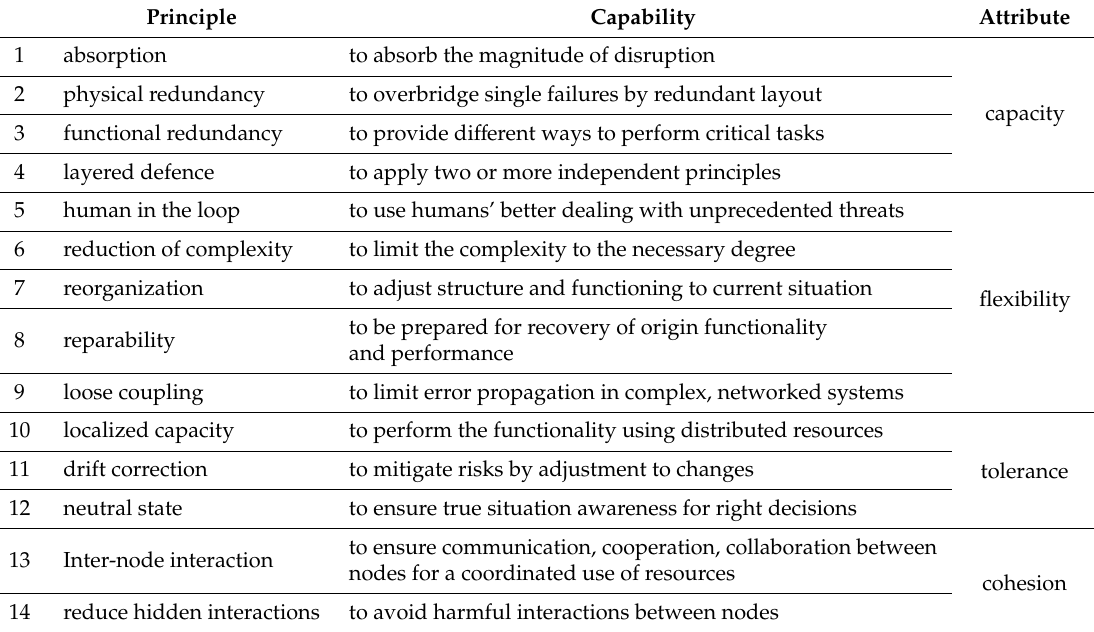
Table 1. Top-level resilience principles, system capabilities, and attributes corresponding to